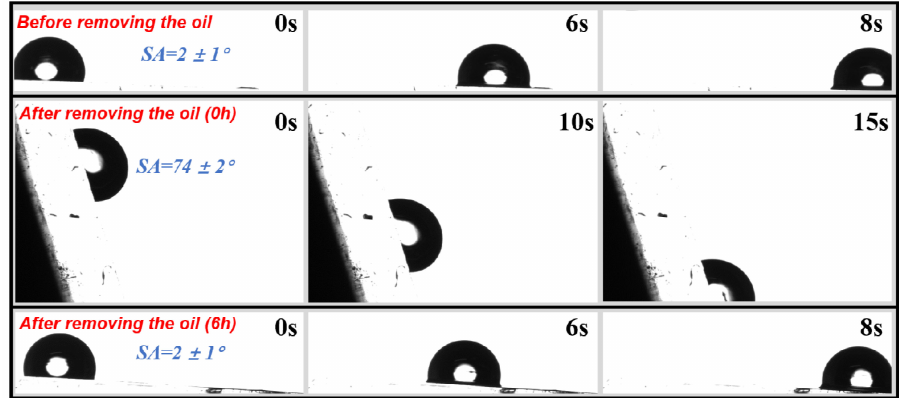
Figure 8. Sliding angles of the 1P2S sample before and after removing the oil from the